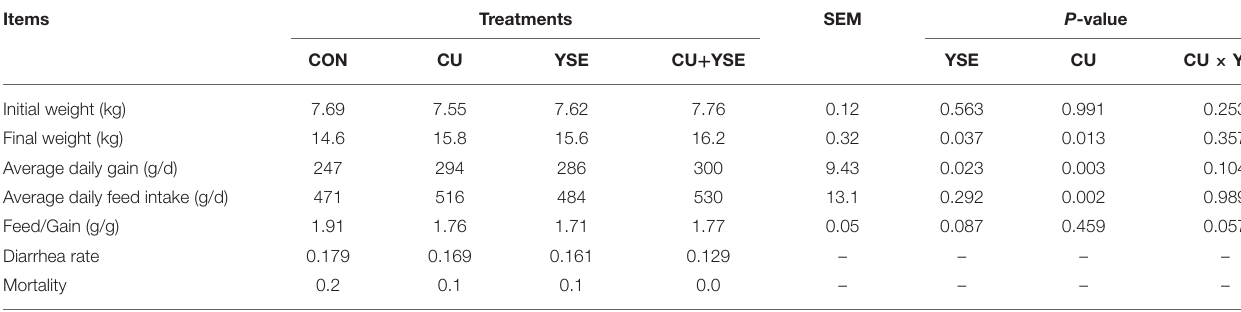
TABLE 2 | Effects of dietary YSE and oral CU on growth performance in weaned piglets. Items Treatments SEM P -value CON CU